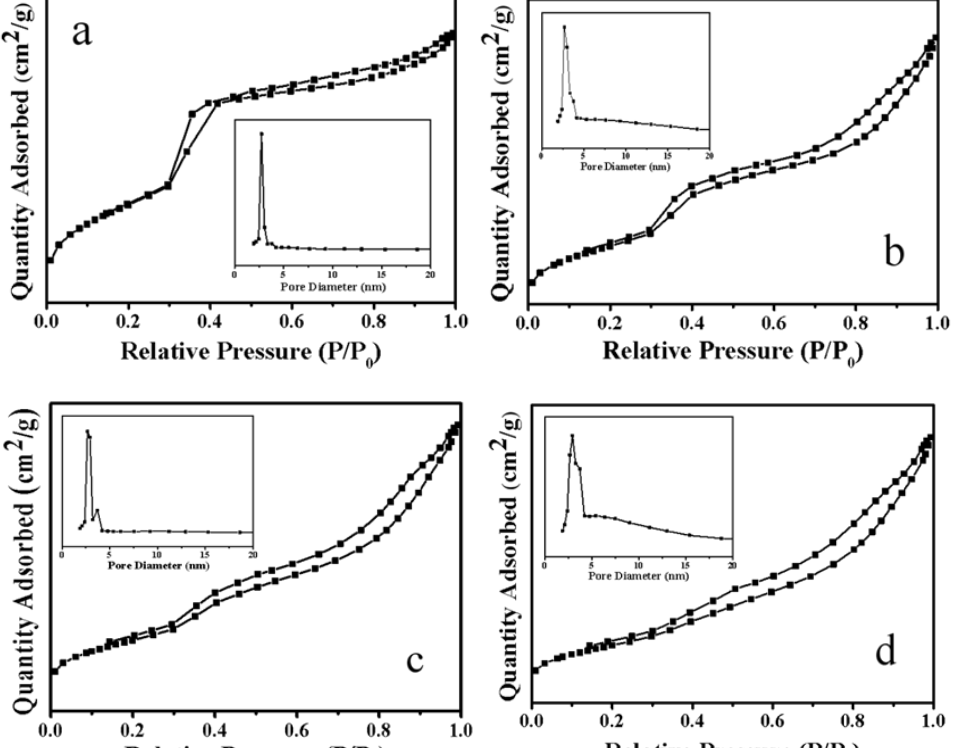
Figure 5. Adsorption-desorption isotherms and pore size distributions of reduced Ni/MCM-41and Ni-MCM-41 catalysts. ( a ) 10%Ni/MCM-41, ( b ) 5%Ni-MCM-41, ( c ) 10%Ni-MCM-41, and ( d ) 15%Ni- MCM-41.